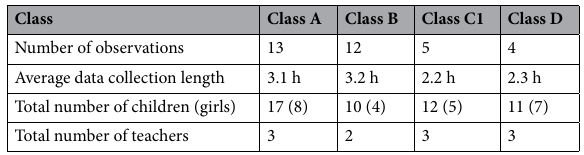
Table 1. Sample characteristics by